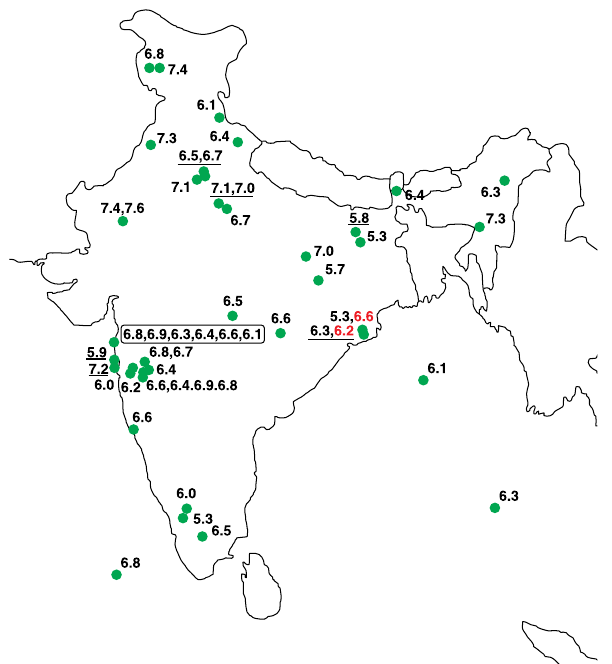
Fig. 27. Values of the pH of rain observed in various studies dur- ing the time period 1963–1999, at Indian Ocean sites and in India (both rural and suburban (underlined) sites), obtained using bulk (black) and wet only (red) collectors (redrawn from Kulshrestha et al., 2005, copyright 2005 by Elsevier, reproduced with